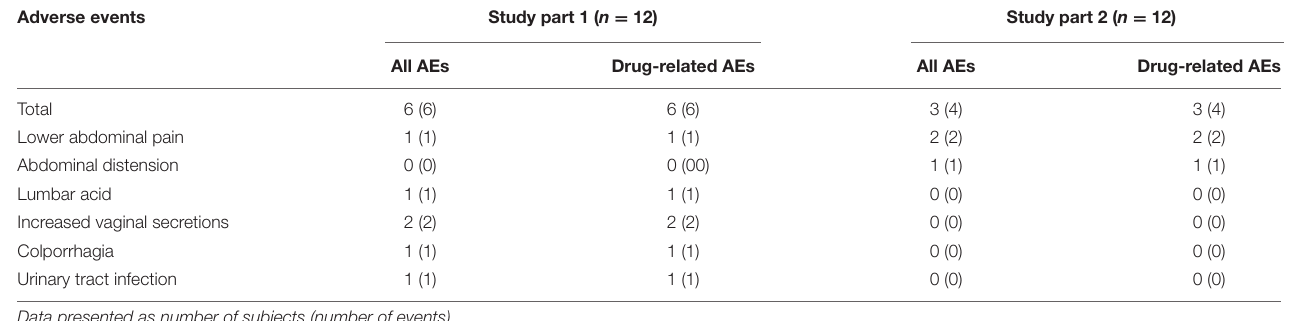
TABLE 2 | Summary of adverse events (AEs) during the study period ( n = 24).